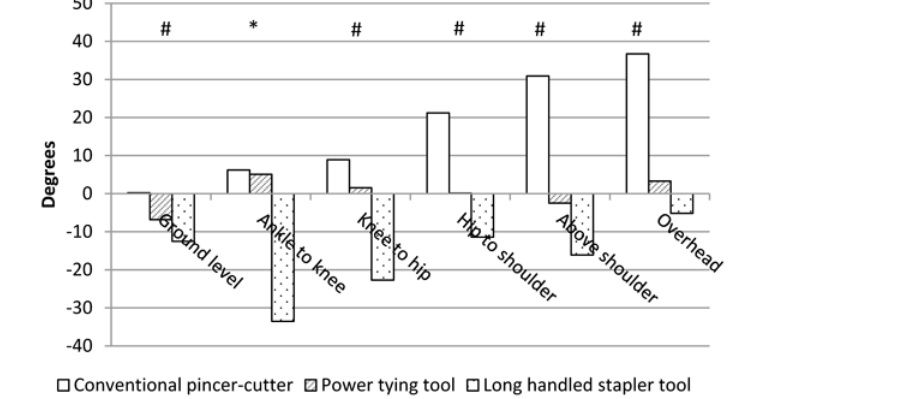
Peak right wrist rotation by tool and work